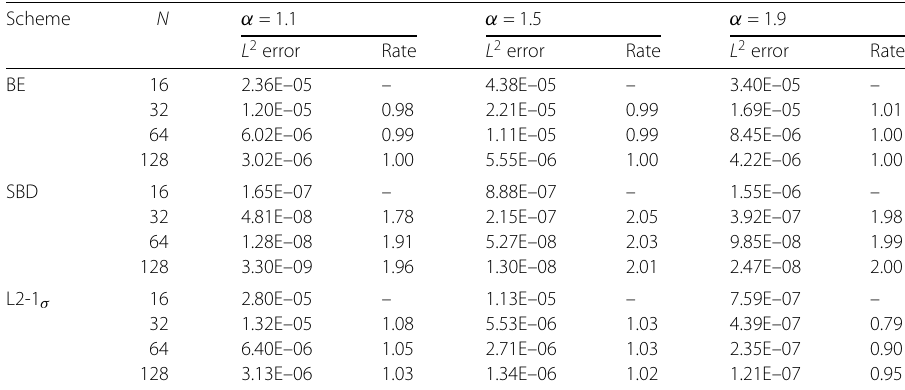
Table 5 The L 2 norm errors in time for case (c) in Example 6.2 with h = 1/10 Scheme